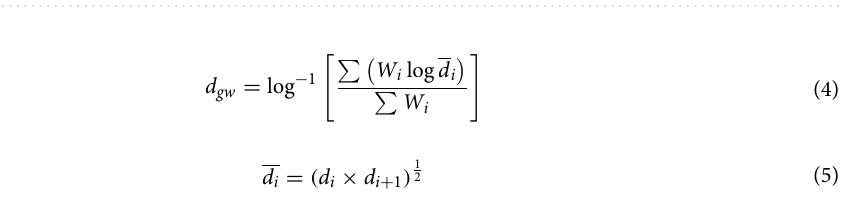
Figure 1. ( a ) Optical photo of untreated Cassia tora L. seeds and the magnified drawing of the seed with denoted dimensions (insert). ( b ) Histogram for the length, thickness and width of Cassia tora L. seeds at initial moisture